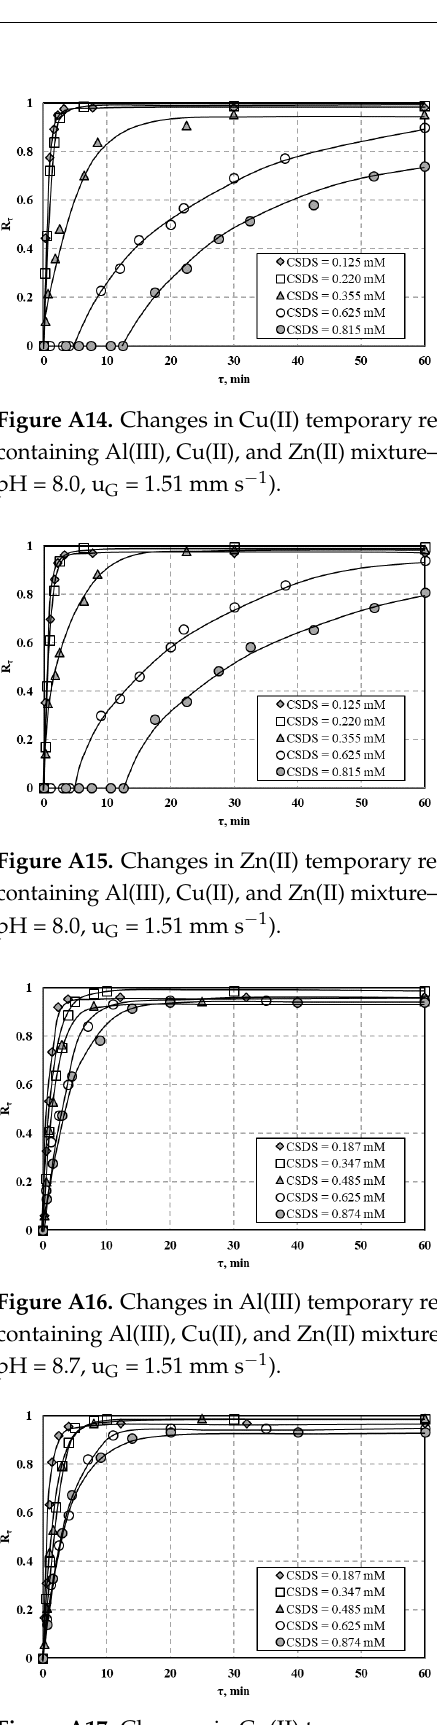
Figure A17. Changes in Cu(II) temporary removal ratio during precipitate flotation from solution containing Al(III), Cu(II), and Zn(II) mixture—effect of collector concentration (c 0 = 2 mmol dm − 3 , pH = 8.7, u G = 1.51 mm s − 1 ).